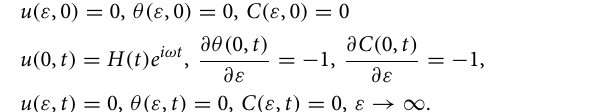
The dimensionless ICs and BCs are as follow and skip ◦ from the non-dimensional factors